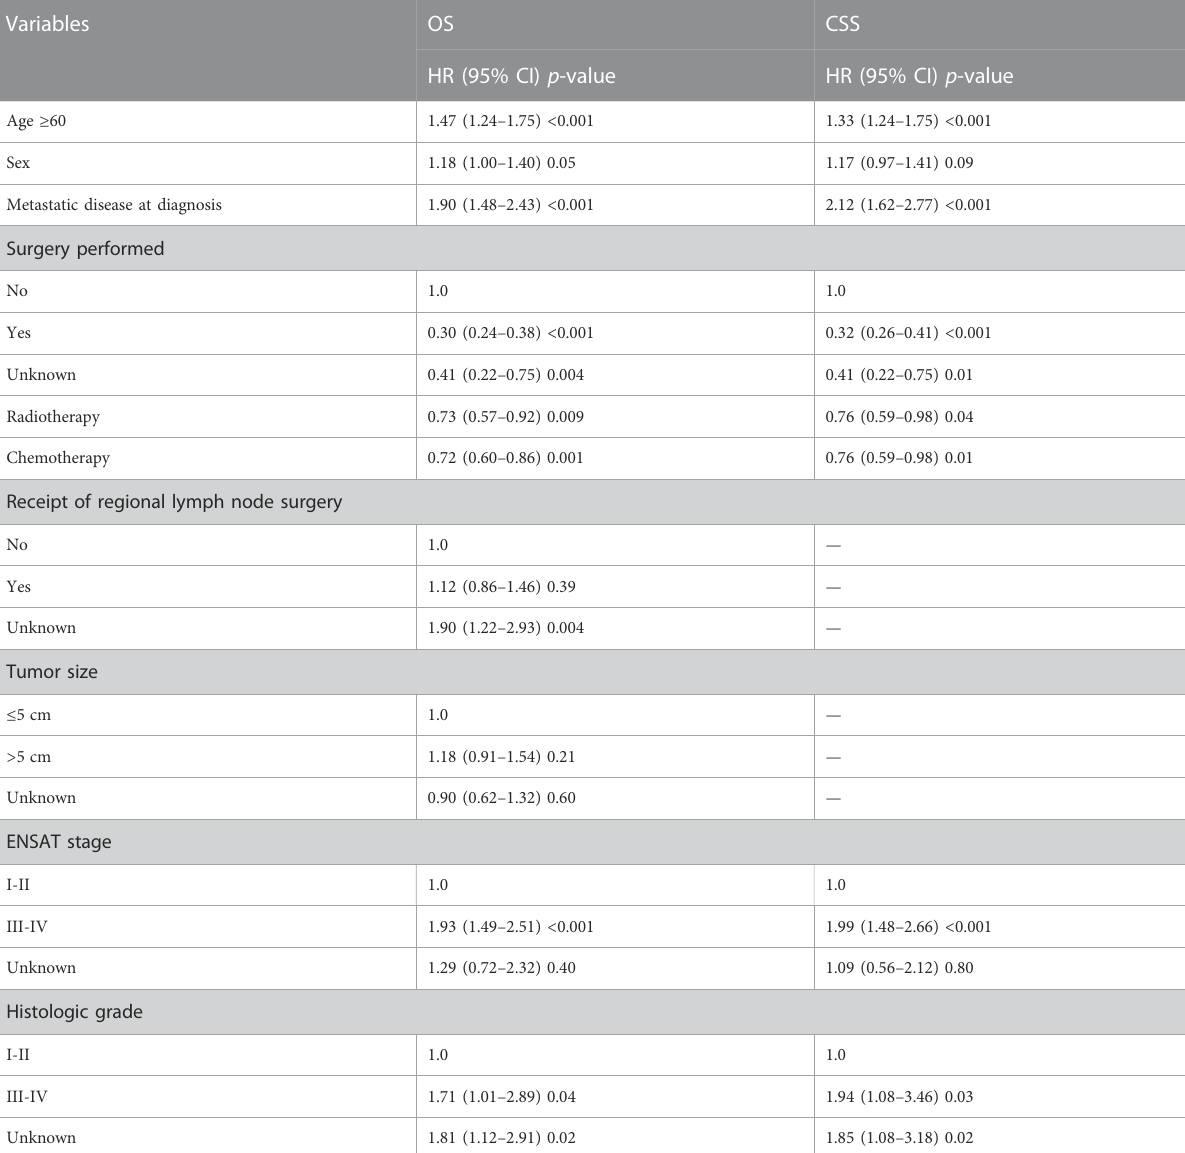
TABLE 3 Multivariable cox regression of affecting overall and cancer speci fi c survival of ACC patients.